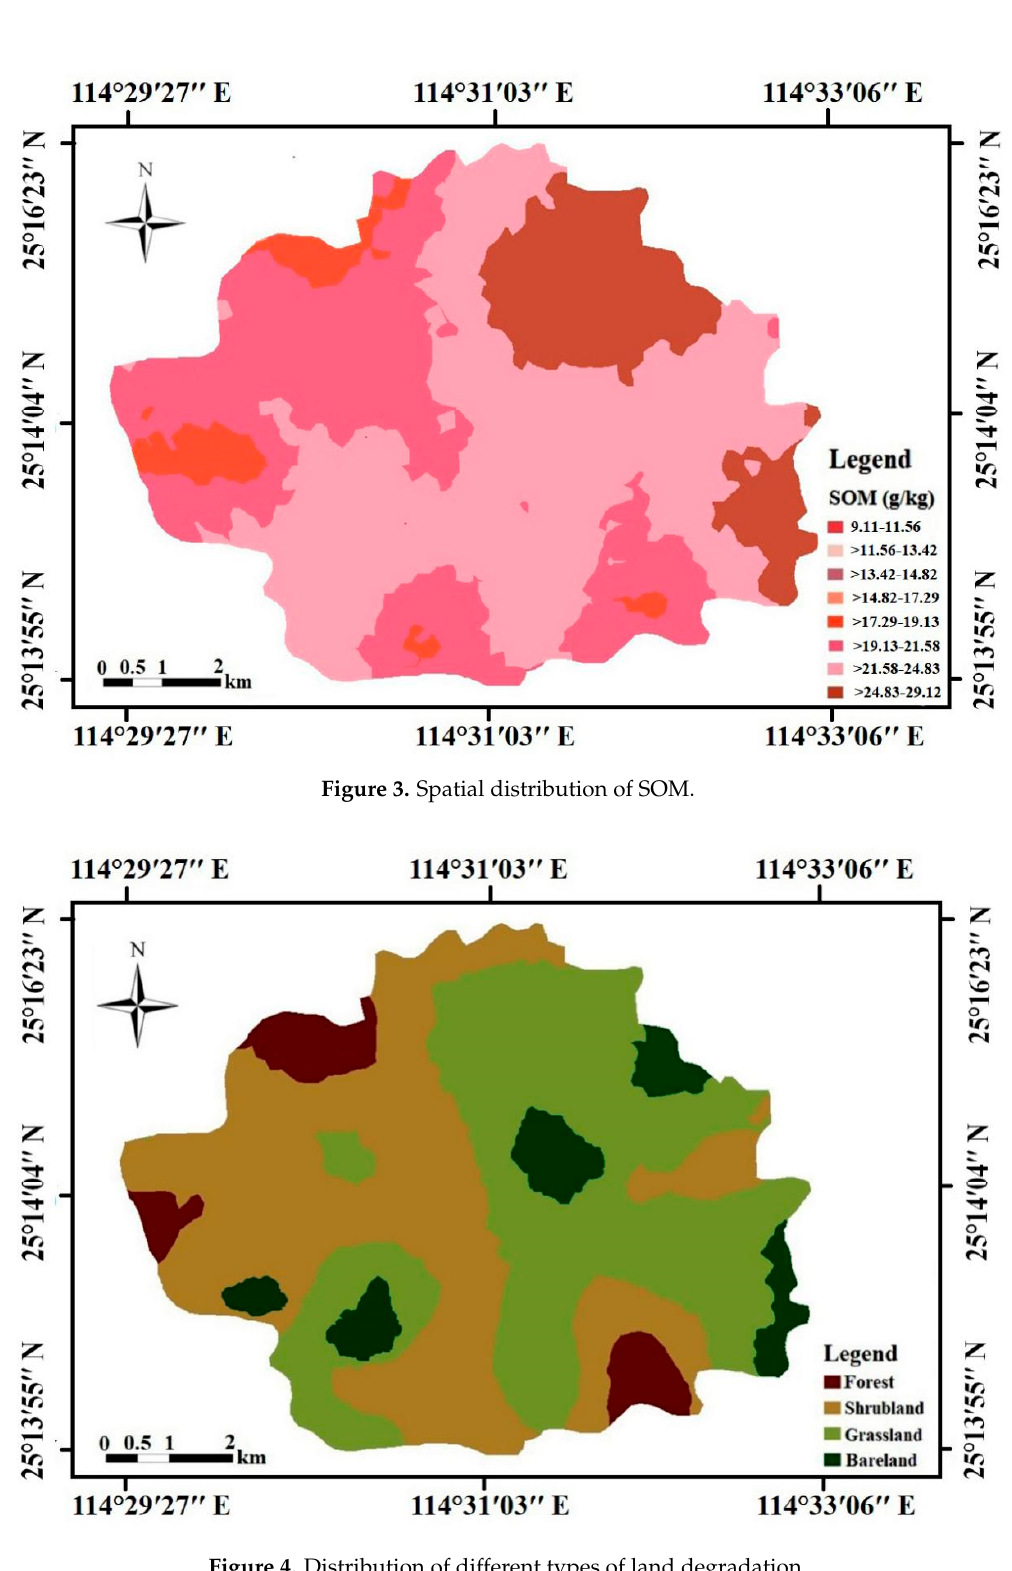
Figure 2. Experimental semi-variograms and fitted models for SOM different land degradation types.